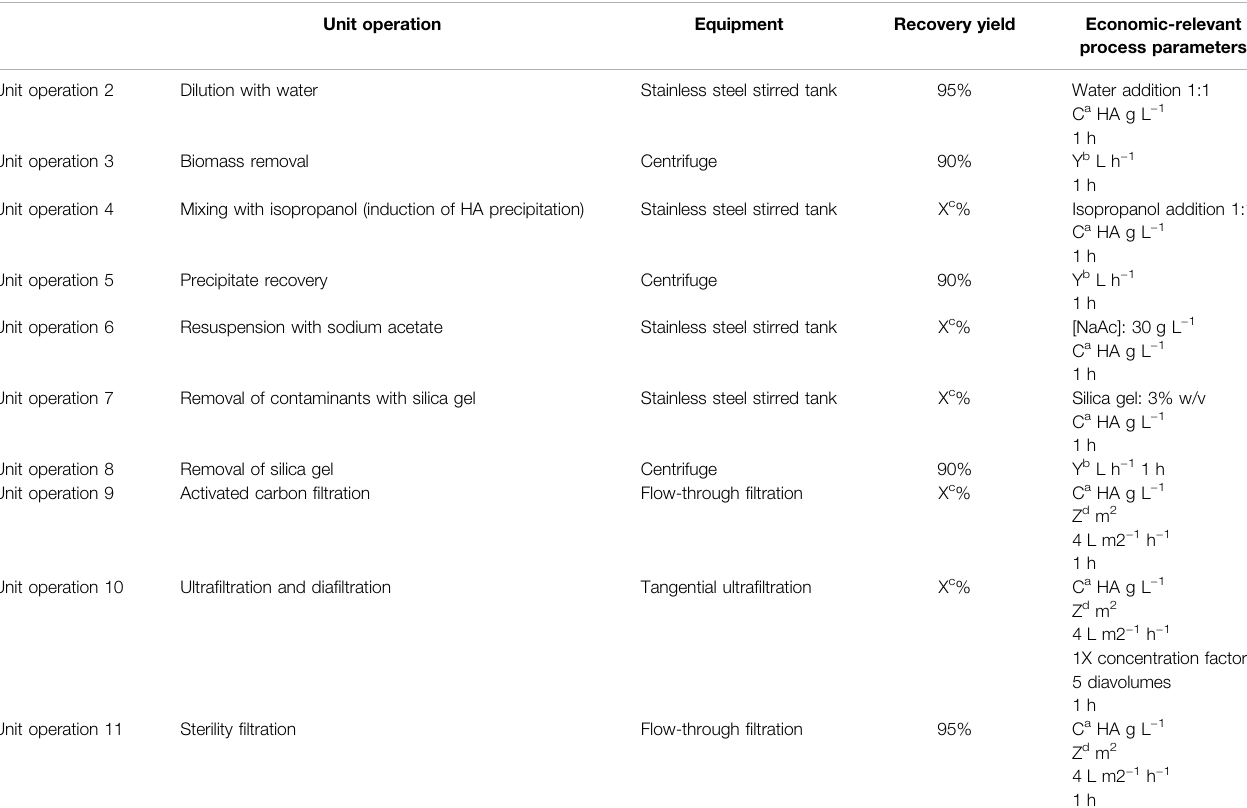
TABLE 2 | Data from hyaluronic (HA) acid downstream processing reports used for model construction. Unit operations were adjusted for duration to be 1 h each (Preparation + Process + Cleaning). Unit operation one corresponds to fermentation (explained in Table 1 ). Letter X, Y, Z, and C were used in substitution of the actual value ofrecovery yield, centrifuge fl ow rate, fi ltration area, and HA concentration, respectively.Actual values for these parameters vary according to the variables analyzed in this